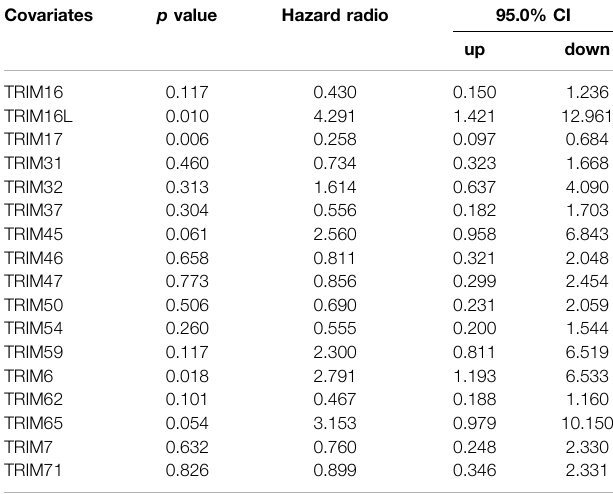
TABLE 2 | The correlation of TRIM genes with the DFS of HBV-positive HCC patients dependent on multivariate analysis in TCGA cohort.